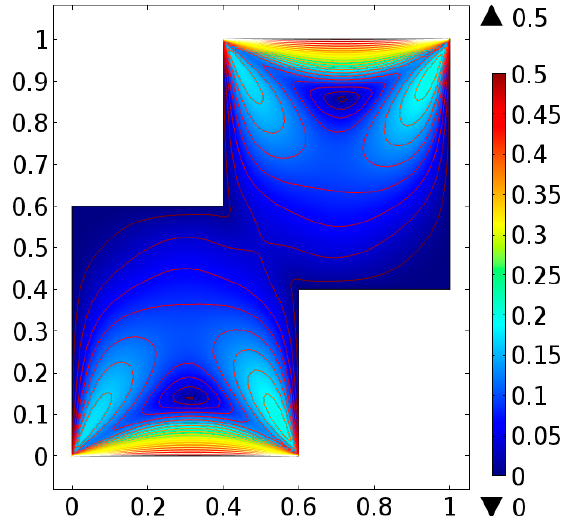
Figure 21. Velocity distribution at Re = 50 for case-II.